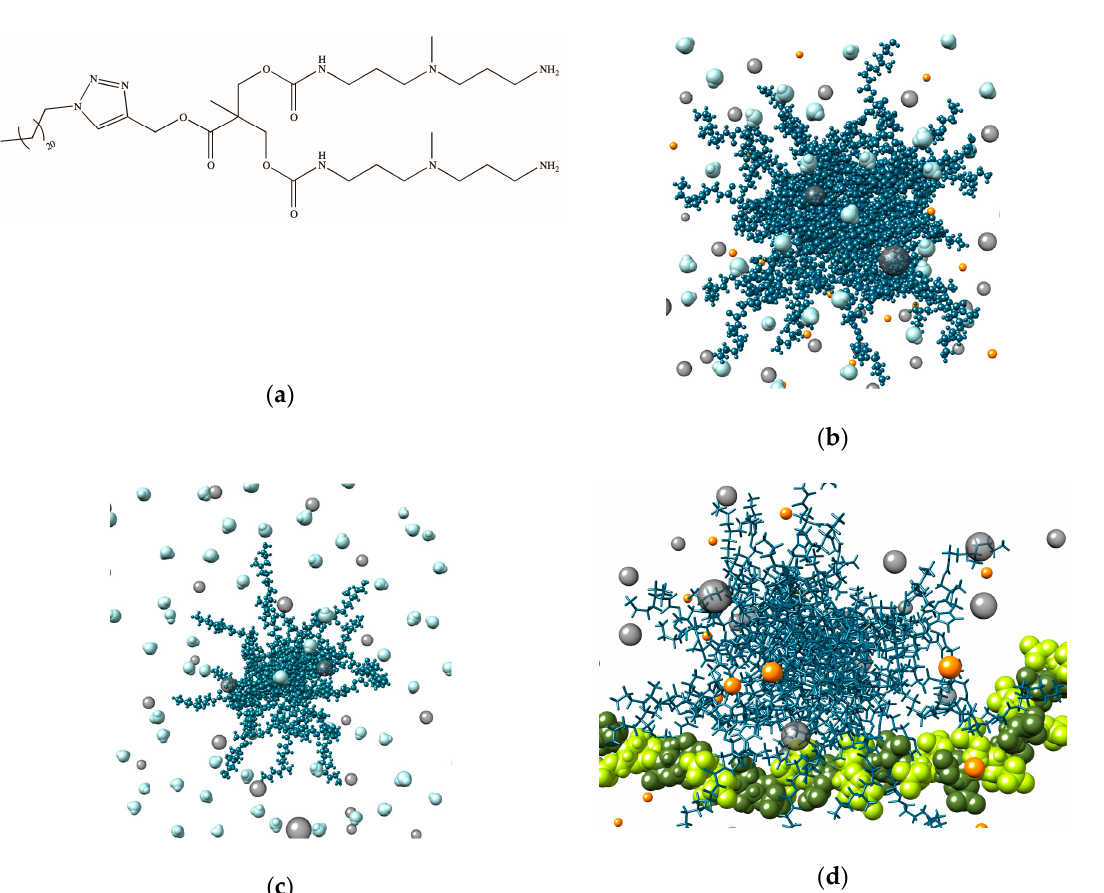
Figure 3. ( a ) Chemical structure of the amphiphilic dendron C 22 G 1 . Atomistic models of the nanomicelles formed by C 22 G 1 under 150 mM NaCl ( b ) and no-salt ( c ) conditions, as obtained from multiscale molecular simulations. In panels ( b ) and ( c ) the C 22 G 1 molecules appear as steel blue sticks-and-balls while some representative water molecules, Na + , and Cl − ions are also shown as light blue, orange, and gray spheres, respectively. ( d ) Atomistic model of a C 22 G 1 self-assembled dendrimer in complex with heparin under 150 nM NaCl conditions. In this panel, the C 22 G 1 molecules are portrayed as steel blue sticks, while heparin is shown as dark olive green ( L -iduronic acid) and light green ( D -glucosamine) spheres. Water molecules are omitted for clarity while some Na + and Cl − ions are shown as orange and gray spheres, respectively. Adapted from [21] with the permission of The Royal Society of Chemistry.